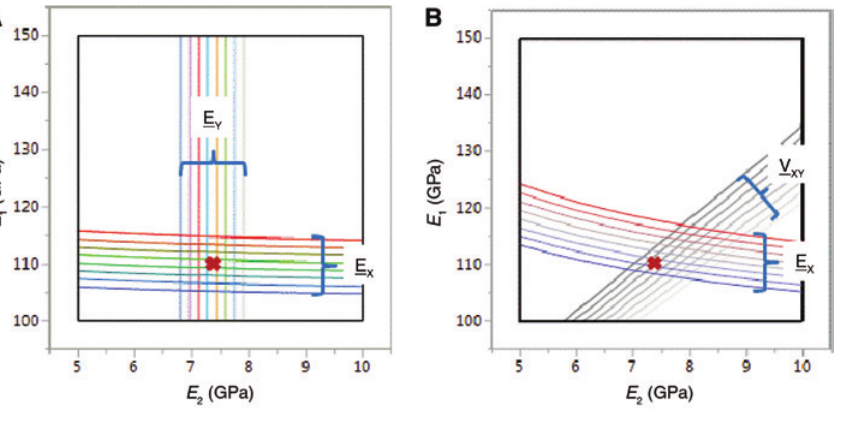
Figure 3: Illustration of the approach to back-calculate nominal UD ply data due to available NCF-made laminate mechanical properties. Contours represent estimated range of laminate longitudinal modulus, E moduli covering the experimental data of the laminates, say (A) laminate ( ± φ ply moduli, E and E which best predicts the available test data of the 1 2